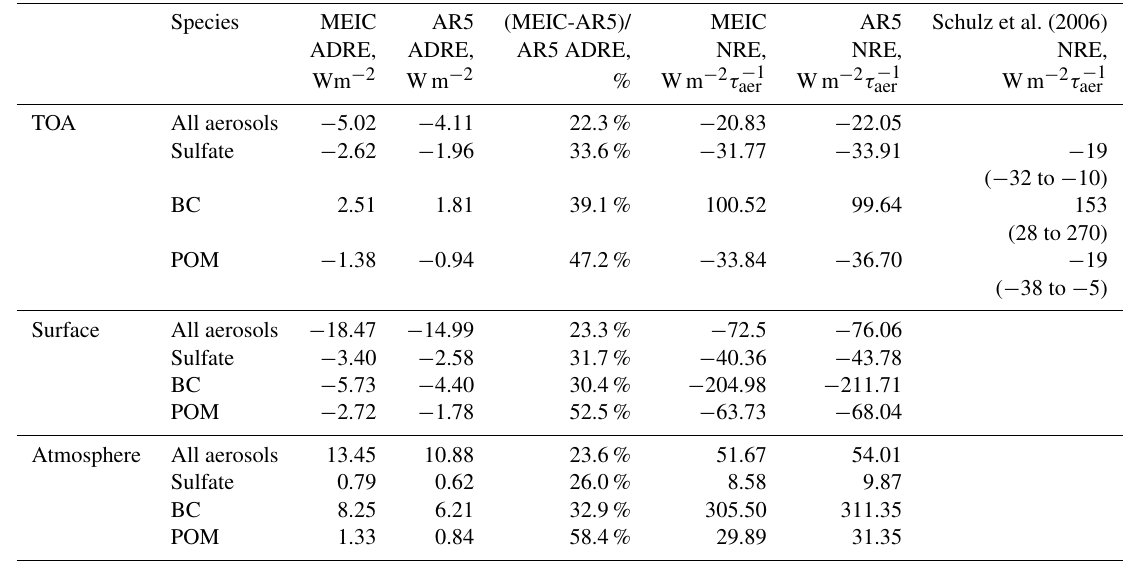
Table 2. Aerosol direct radiative effects (ADREs) and the normalized radiative effect (NRE) averaged over eastern China in 2009 simulated using the MEIC and the AR5 emissions.